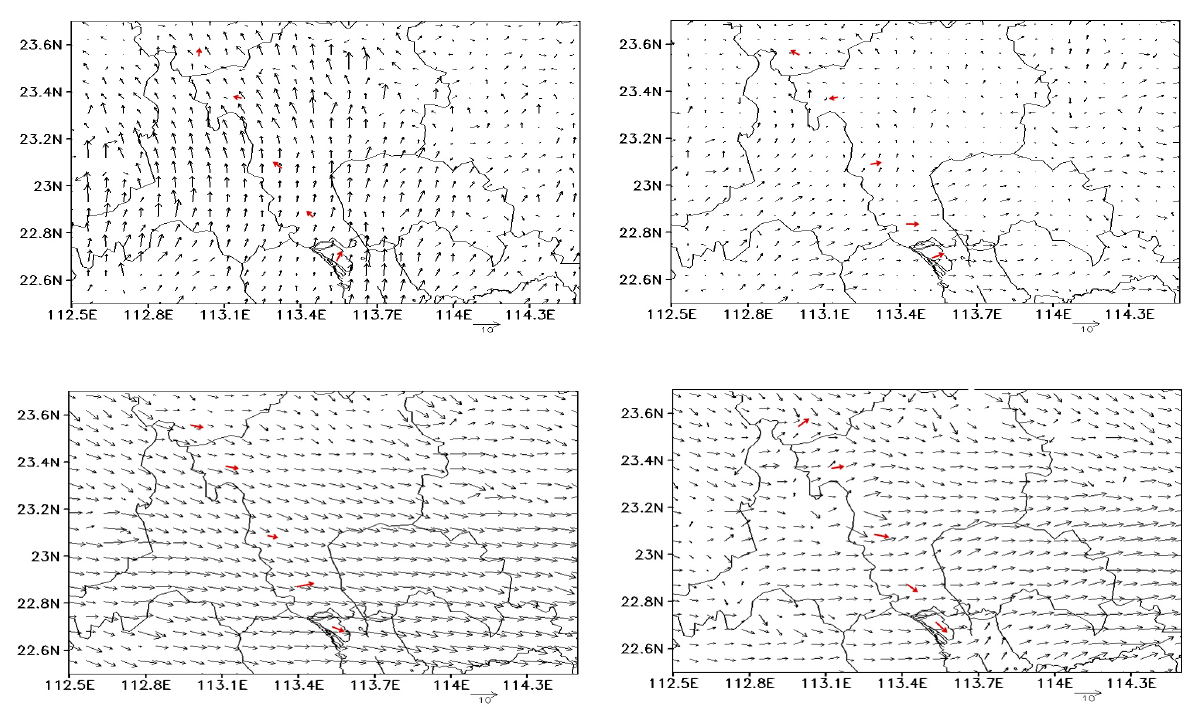
Fig. 10. Measured (red arrows) 10m wind (ms-1) from the main meteorological stations in Fig. 1b and modeled WRF wind field (black arrows) over the PRD region. (a) 20:00 LST on 12 July. (b) 02:00 LST on 13 July. (c) 08:00 LST on 14 July. (d) 14:00 LST on 14